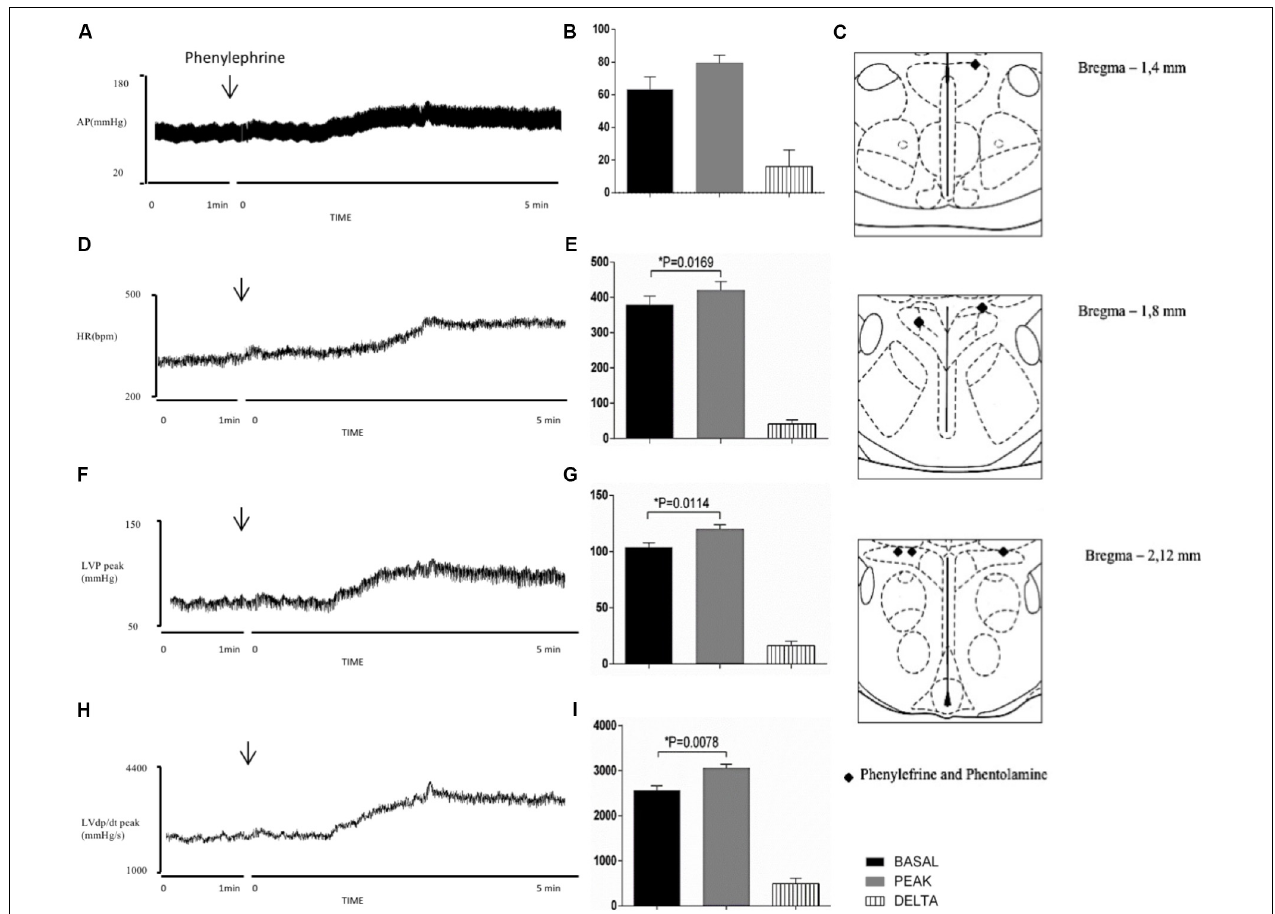
FIGURE 4 | Left column – Chart records illustrating the responses of MAP (A) , HR (D) , LVP peak (F) and LVdP/dt peak (H) produced by the unilateral microinjection of phenylephrine into PVN (arrows indicate the moment of injection). Middle column – Mean maximal changes in MAP (B) , HR (E) , LVP peak (G) , and LVdP/dt peak (I) in response to unilateral microinjections of phenylephrine (100 nl). Values refer to the means collected in the basal period (2 min before the central injection), and at the maximum point of response to microinjection and its variation. ∗ P < 0.05. MAP, mean arterial pressure; HR, heart rate; LVP peak, maximum pressure in the left ventricle; LVdP/dt peak, first derivative of cardiac left ventricle pressure. Right column – Schematic representation of the injection sites stained by Evans blue dye from group injected with phenylephrine and phentolamine (100 nl) group into PVN (C) . n =